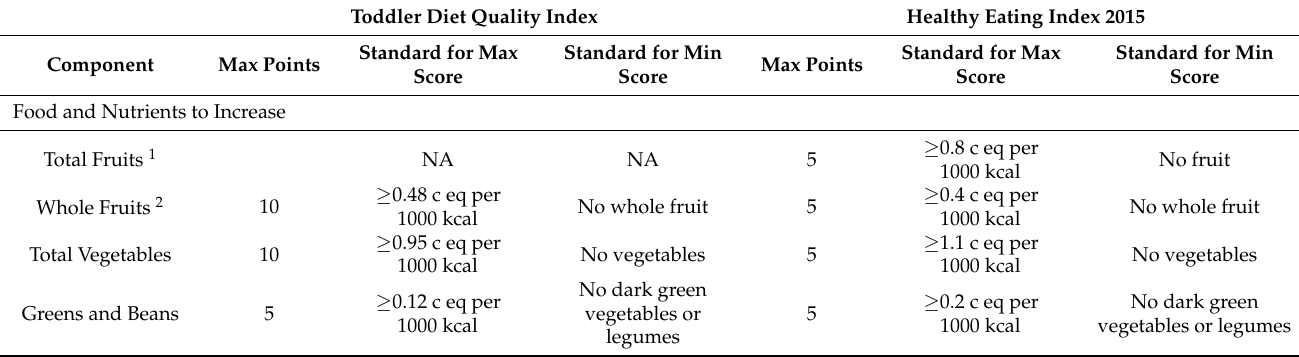
Table 1. Comparison of components and scoring standards for the Toddler Diet Quality Index for U.S. children aged 12 to 23.9 months not consuming human milk or infant formula and the Healthy Eating Index 2015 for those aged 2 years and older in the